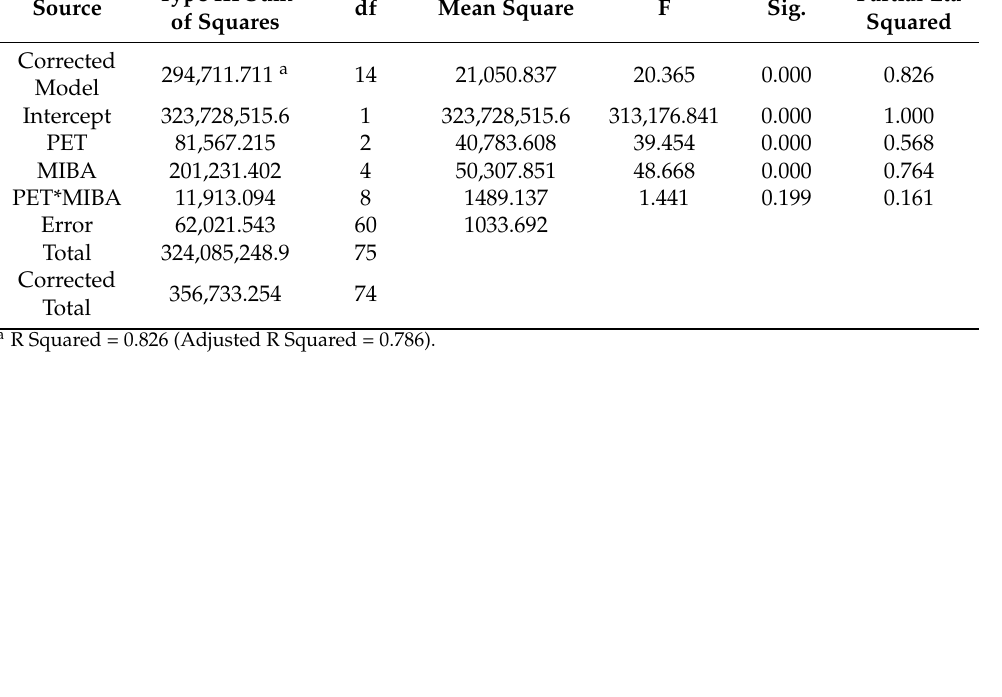
Figure 10. The average density of mortar specimens. The density analysis results (Table 6) revealed that the amount of PET pellets and MIBA significantly affected the specimen’s density. It can be observed that there is no interaction effect when using PET pellets with MIBA, F(8, 60) = 1.44, p = 0.2. The plots of the estimated marginal mean for different replacement levels of PET and MIBA (Figure 11) show a similar trend to the compressive strength plot. Table 6. Density tests between PET pellets and MIBA effects. Test of Between-Subjects Effects. Dependent Variable: